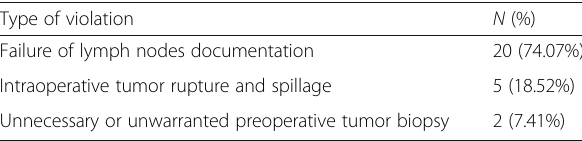
Table 2 The types and rates of surgical violations practiced in this study